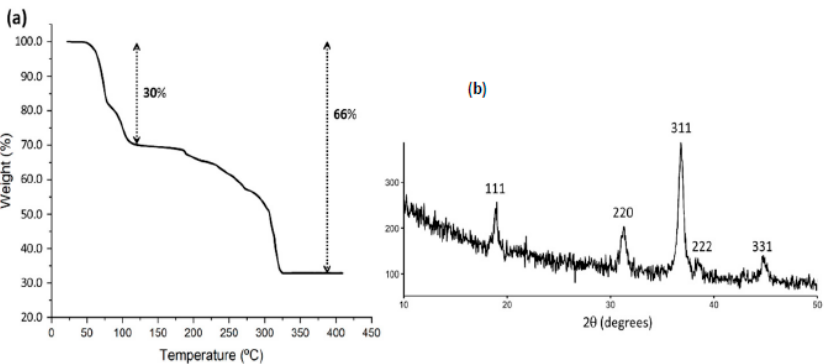
Figure 13. ( a ) TGA plot for the decomposition of a cobalt (II) acetate tetrahydrate commercial sample under air atmosphere; ( b ) XRD pattern of the final product of the ATG analysis. All the intense maxima correspond to the Co 3 O 4 spinel.